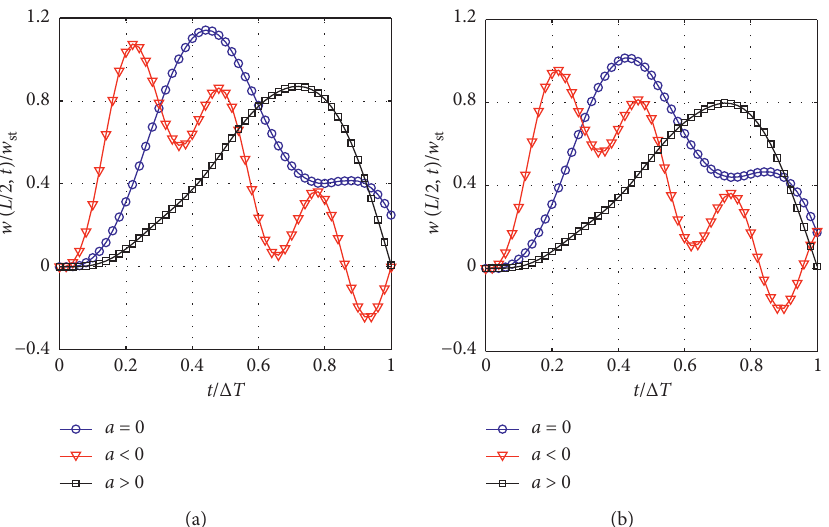
Figure 10: Time histories for midspan dimensionless deflection of BFGSW beam under different motions for n (a) (2-1-2) beam. (b) (2-2-1) beam.